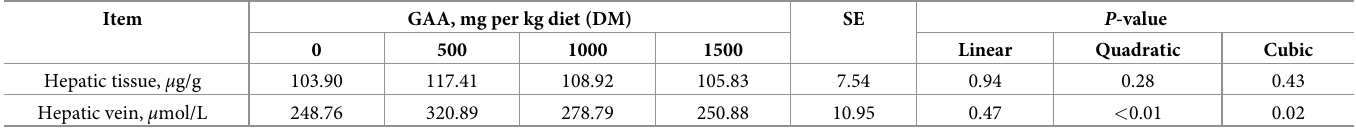
Table 6. Effects of supplementation with guanidinoacetic acid on creatine concentration in hepatic vein plasma and hepatic tissue of lambs. Item